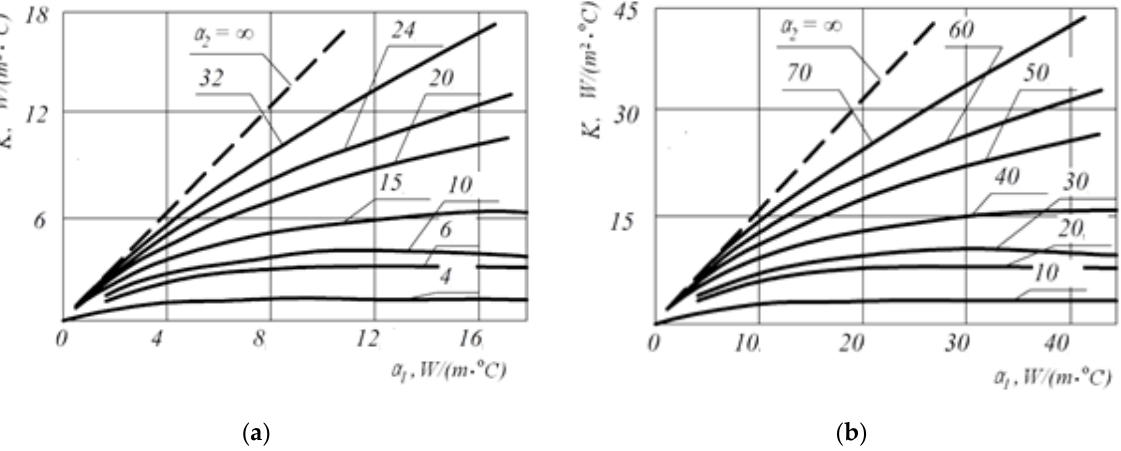
Figure 6. Change in the heat transfer coefficient K depends on the heat transfer coefficient from the outer α 1 and inner α 2 surfaces of the left half-disc self-ventilated brake disc of a MAN truck model TGA 26.430 when driving at a speed of: ( a ) 30 km/h; ( b ) 60 km/h [24].